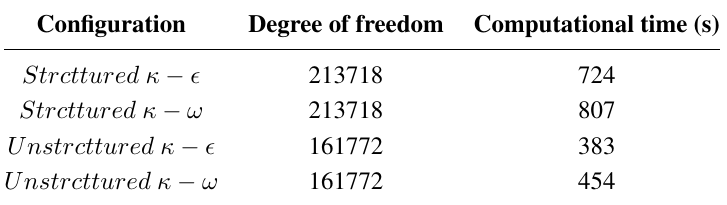
Table 1. Average value for parametric sweep simulation from 0 ◦ to 180 ◦ .